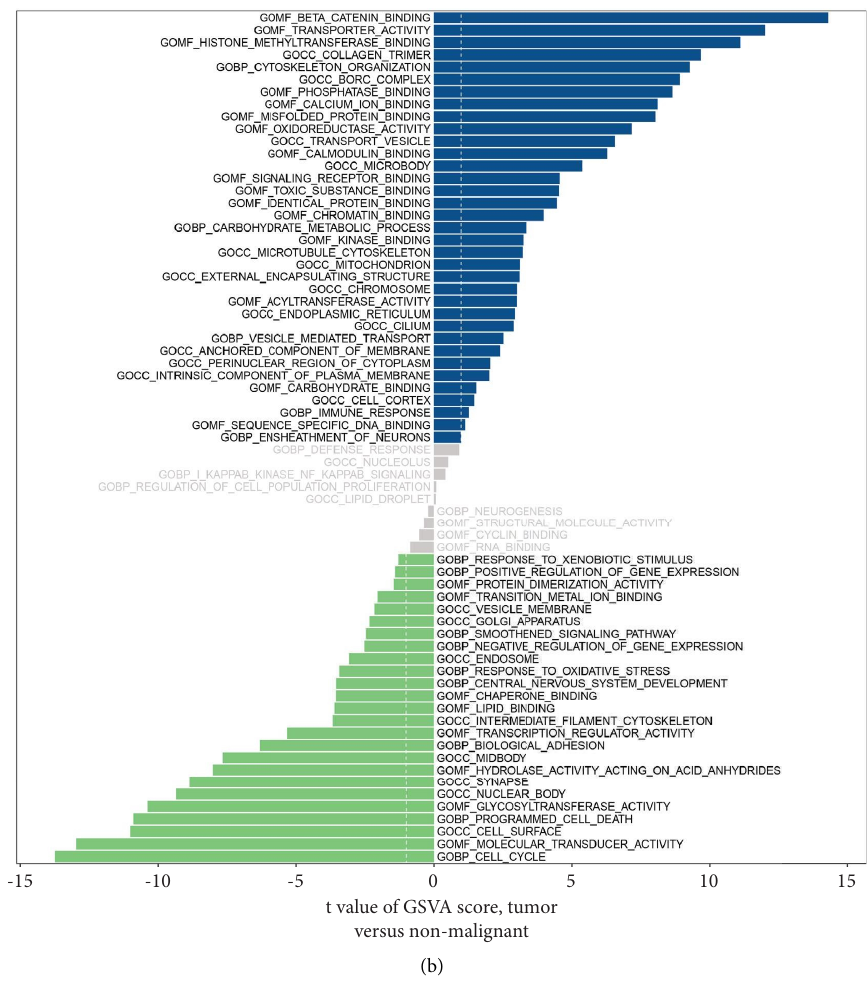
Figure 6: (a) Te GSVA analysis of low- and high-CCND1 groups. (b) Te GSVA analysis of low- and high-NR3C2